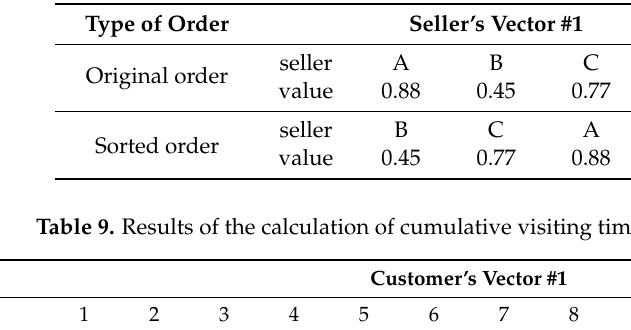
Table 8. Results of sorting the seller’s vector.